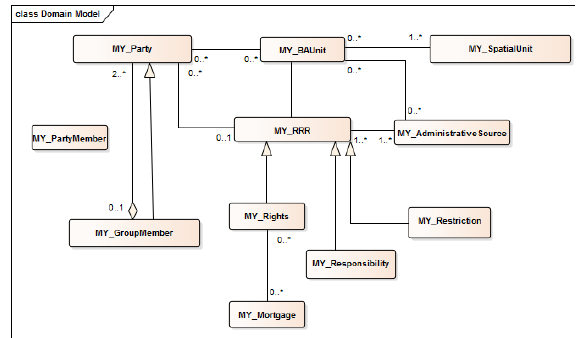
Figure 12. Non-spatial component data